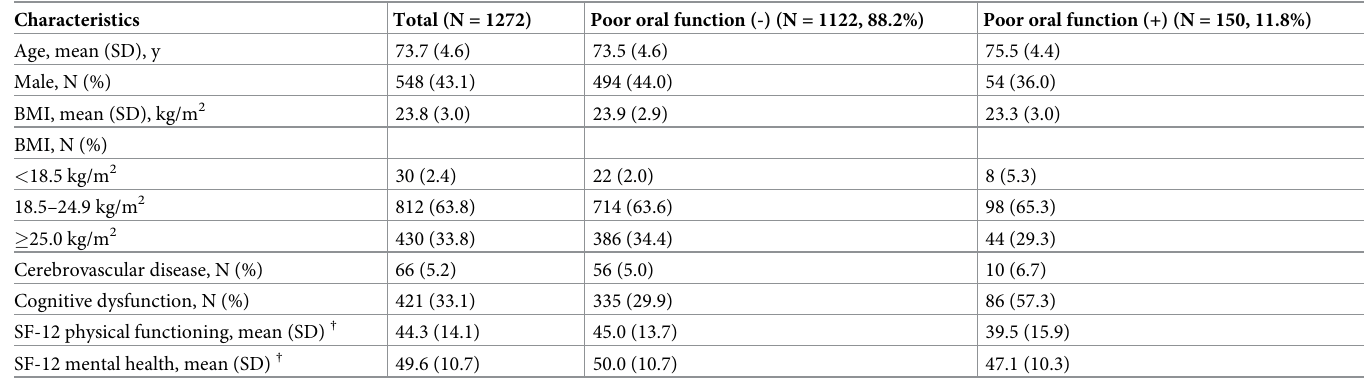
Table 1. Baseline characteristics of the study participants.